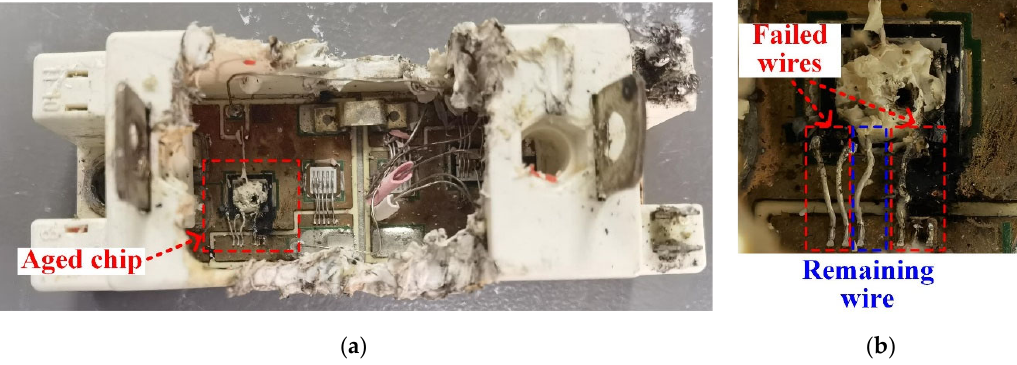
Figure 17. Cycling results of IGBT module SKM50GB12T4: ( a ) whole module; ( b ) failed wires.